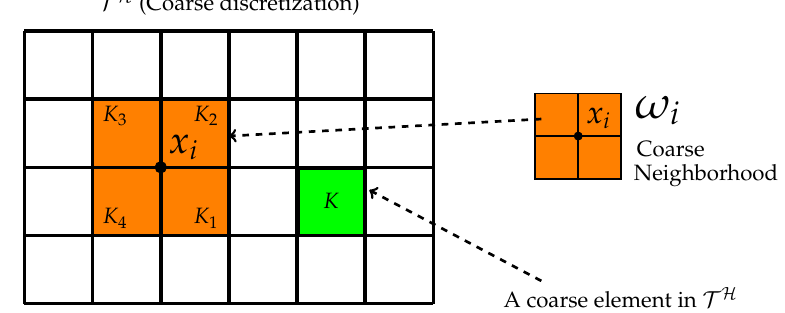
Figure 1. Illustration of a coarse neighborhood and a coarse